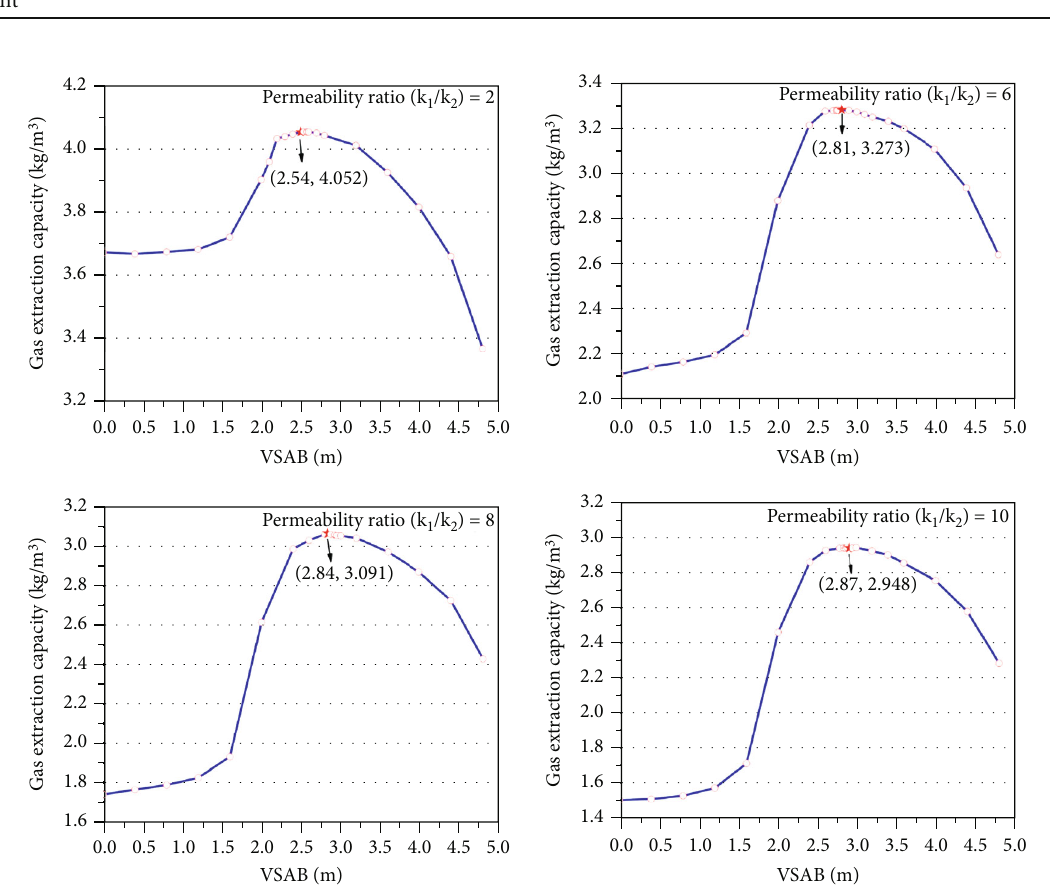
Figure 7: Relationship between gas extraction capacity and VSAB under di ff erent coal seam permeability ratios.